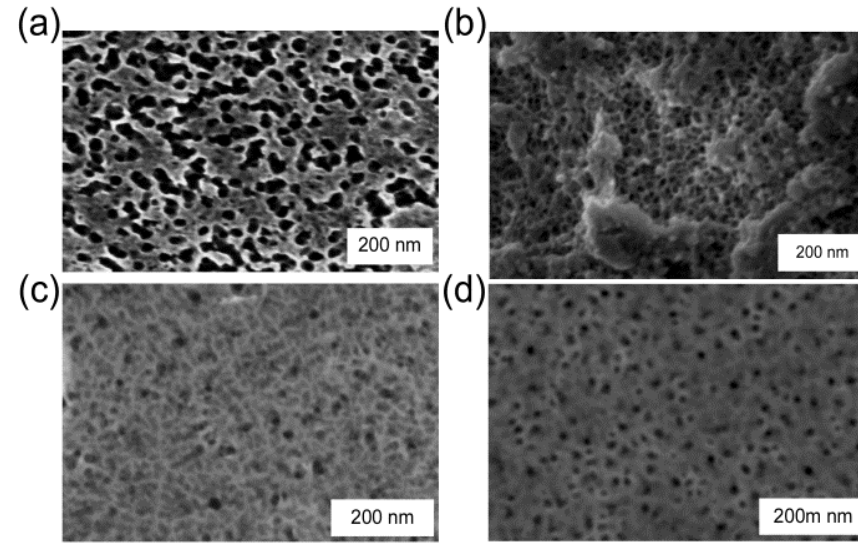
Figure 1 . Scanning electron microscope images of nanoporous sponges prepared in Au by de-alloying AuAl 2 , ( a ) thin film showing irregularly-shaped ligaments and pores (image courtesy of Dr. A Maaroof, 0.2 M NaOH, ~3 min); ( b ) de-alloyed bulk AuAl 2 showing foamy sponge (0.1 M NaOH, room temperature, 30 min); ( c ) sponge with skeletal morphology produced from a 72 at.% Al precursor (0.1 M NaOH, 2 min); ( d ) “pinhole”-type sponge produced from a 66 at.% Al precursor (0.1 M NaOH, 4